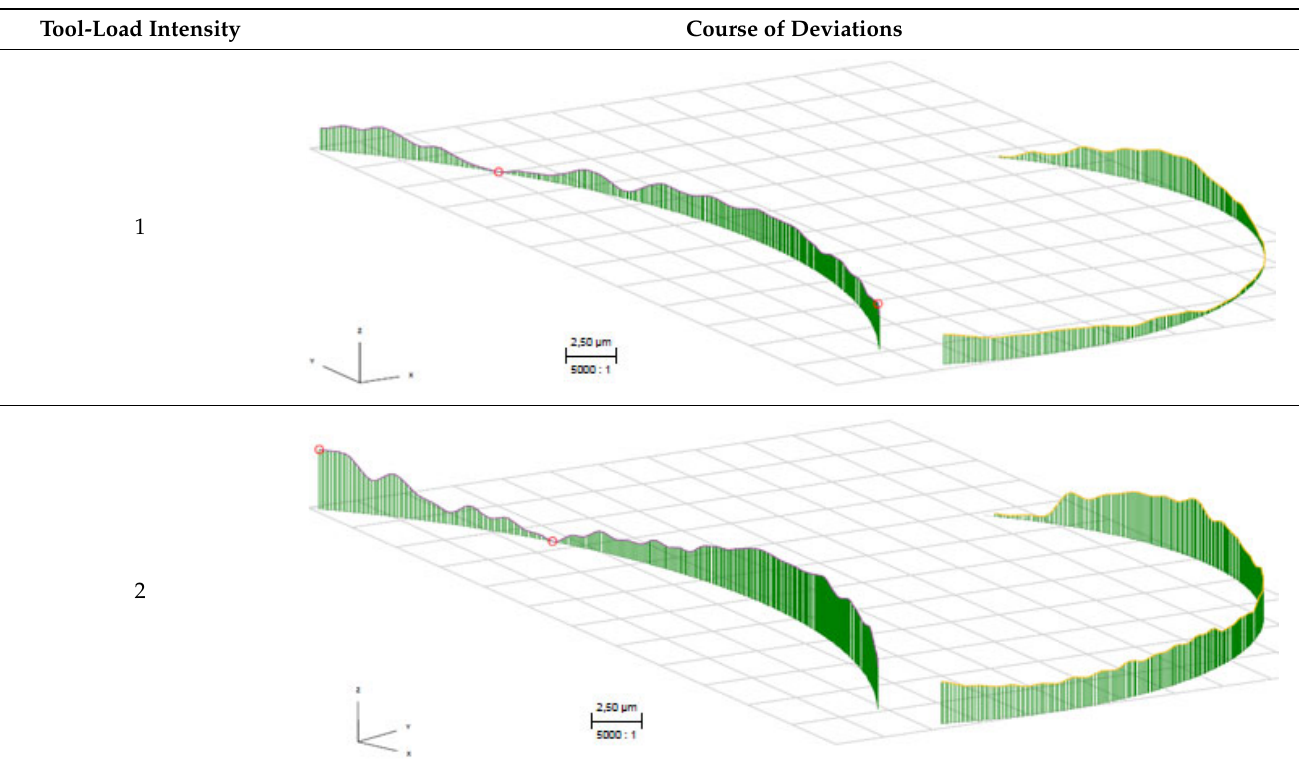
Table 5. Deviations at the bottom of the pockets made with the CAM system.